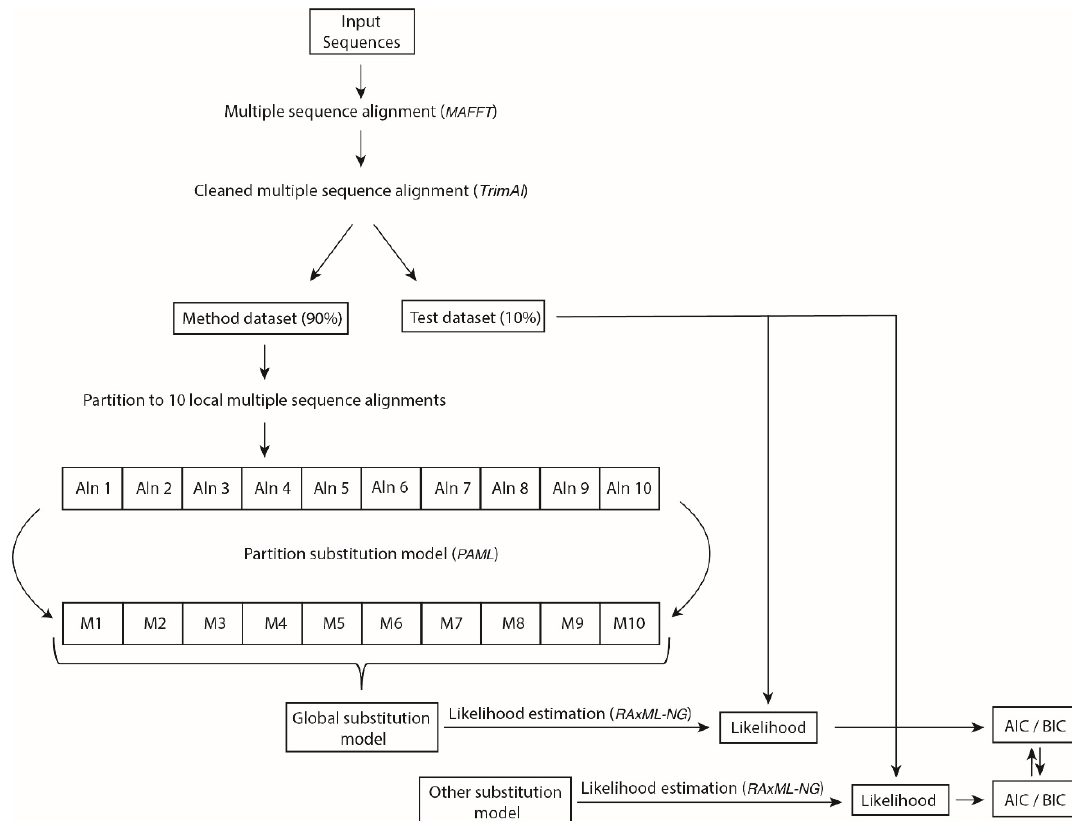
Figure 1. Pipeline for the inference and evaluation of the empirical substitution models of PR and IN evolution. The input protein sequences were aligned and cleaned (removing duplicate sequences and uninformative sites). Next, the resulting multiple-sequence alignment (MSA) was split into two datasets: a method dataset (for the inference of the substitution model, including most of the sequences) and a test dataset (for the evaluation of the substitution model). Indeed, the method dataset was split into 10 local method datasets (due to computational limitations), and we inferred a local (partition) substitution model for each one. The resulting local substitution models were averaged to obtain a global substitution model. Finally, we calculated the AIC and BIC scores for the global substitution model and other currently available empirical substitution models in order to evaluate them, considering the likelihood of every model with the test dataset.